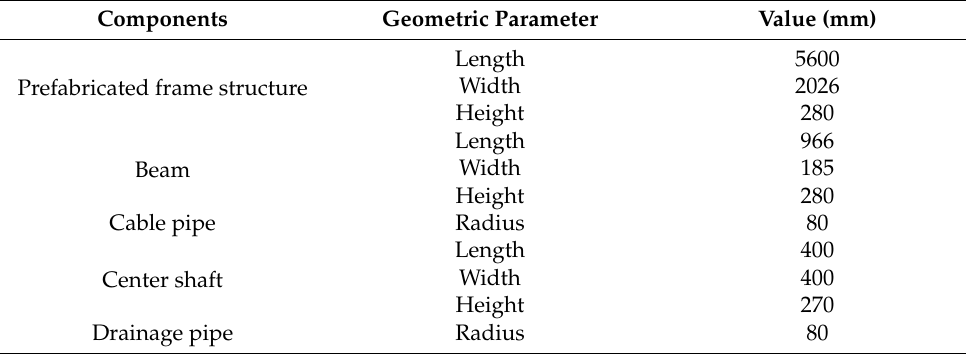
Table 1. The main geometric dimensions of NFET.